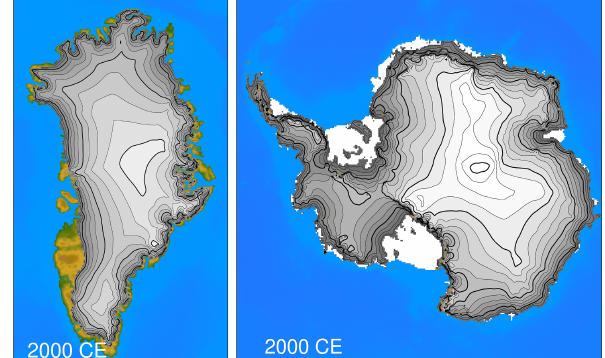
Figure 1. The Greenland ice sheet and the Antarctic ice sheet ge- ometry after the spin-up procedure at